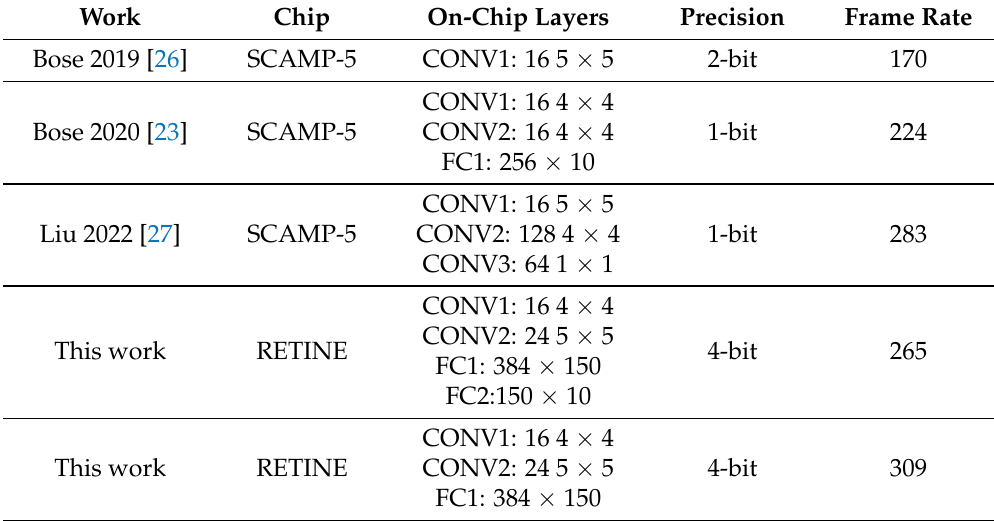
Table 4. Benchmarking frame rate against convolutional models implemented on the SCAMP-5 pixel-array